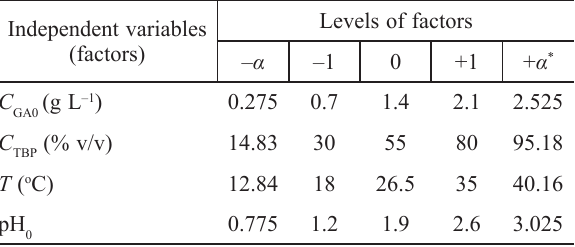
Table 2 – Levels of independent variables used for rotatable orthogonal central composite design